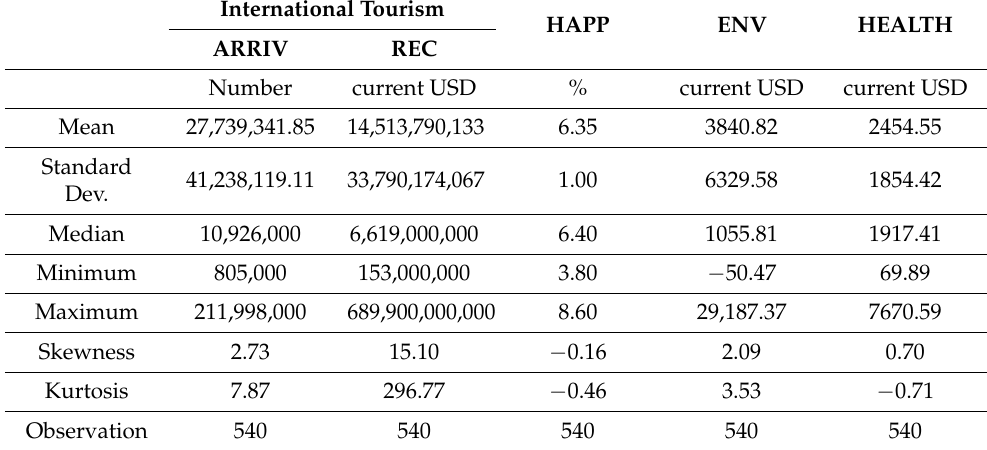
Table 2. Descriptive